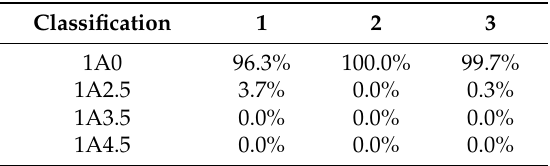
Table 6. Recognition results of the tracking and erosion resistance of samples below 1A0 using the LIBS technique based on the neural network algorithm.